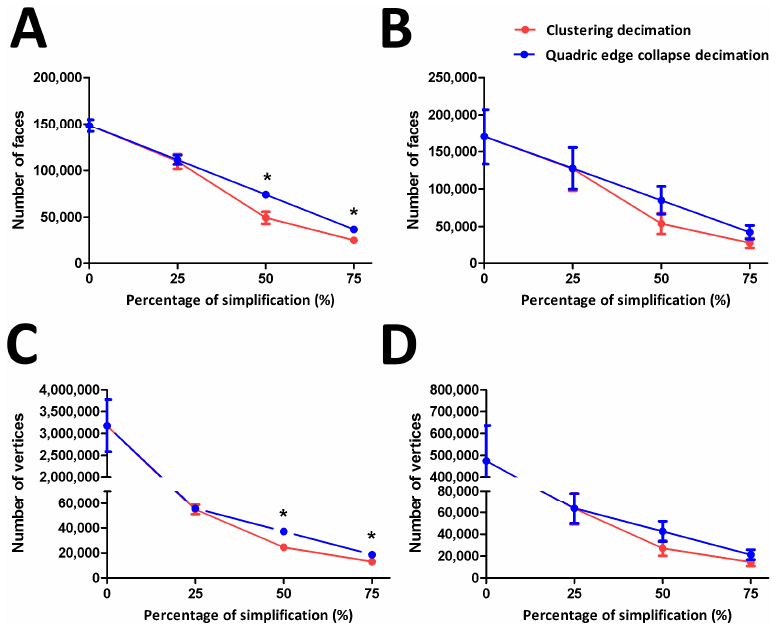
Figure 2. Number of faces and vertices of FtMt and LC3 3D models before and after the simplification procedure. ( A ). Number of faces of FtMt 3D models before and after 25%, 50%, and 75% simplification through CD and QECD. There was a significant decrease in the number of faces undergoing CD at 50% and 75% simplification compared to QECD. ( B ). Number of faces of LC3 3D models before and after 25%, 50%, and 75% simplification through CD and QECD. There was no significant difference in the number of faces undergoing CD at 25%, 50% and 75% simplification compared to QECD. ( C ). Number of vertices of FtMt 3D models before and after 25%, 50%, and 75% simplification through CD and QECD. There was a significant decrease in the number of faces undergoing CD at 50% and 75% simplification compared to QECD. ( D ). Number of vertices of LC3 3D models before and after 25%, 50%, and 75% simplification through CD and QECD. There was no significant difference in the number of vertices undergoing CD at 25%, 50%, and 75% simplification compared to QECD. 0% indicate the original number of faces and vertices, respectively. * demonstrates a statistically significant difference ( p < 0.05) between CD and QECD at a particular simplification percentage. Data are presented as the mean ± standard deviation (SD).